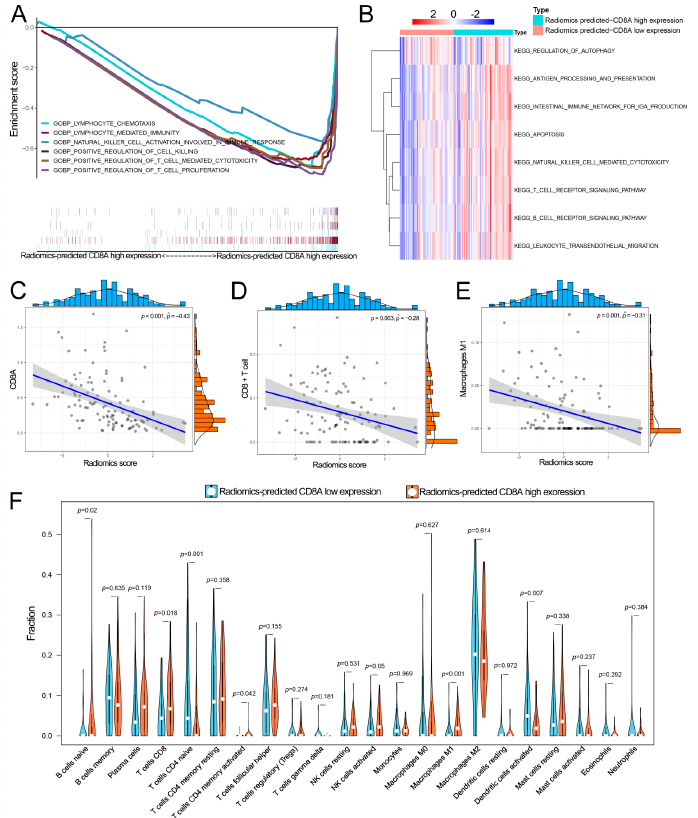
Figure 8. Biological analysis of the radiomics signature (LASSO model). ( A , B ) Gene set enrichment analysis ( A ) and gene set variation analysis ( B ) for comparing biological pathways between radi- omics-predicted high and low CD8A expression groups. ( C – E ) The association of radiomics score with CD8A expression, CD8A ( C ) and degree of infiltration of CD8+ T cells ( D ) and Macrophages M1 ( E ). ( F ) The difference of the proportions of 22 TIICs between radiomics-predicted high and low CD8A expression groups. LASSO, least absolute shrinkage and selection operator; TIICs, tumor- infiltrating immune cells.